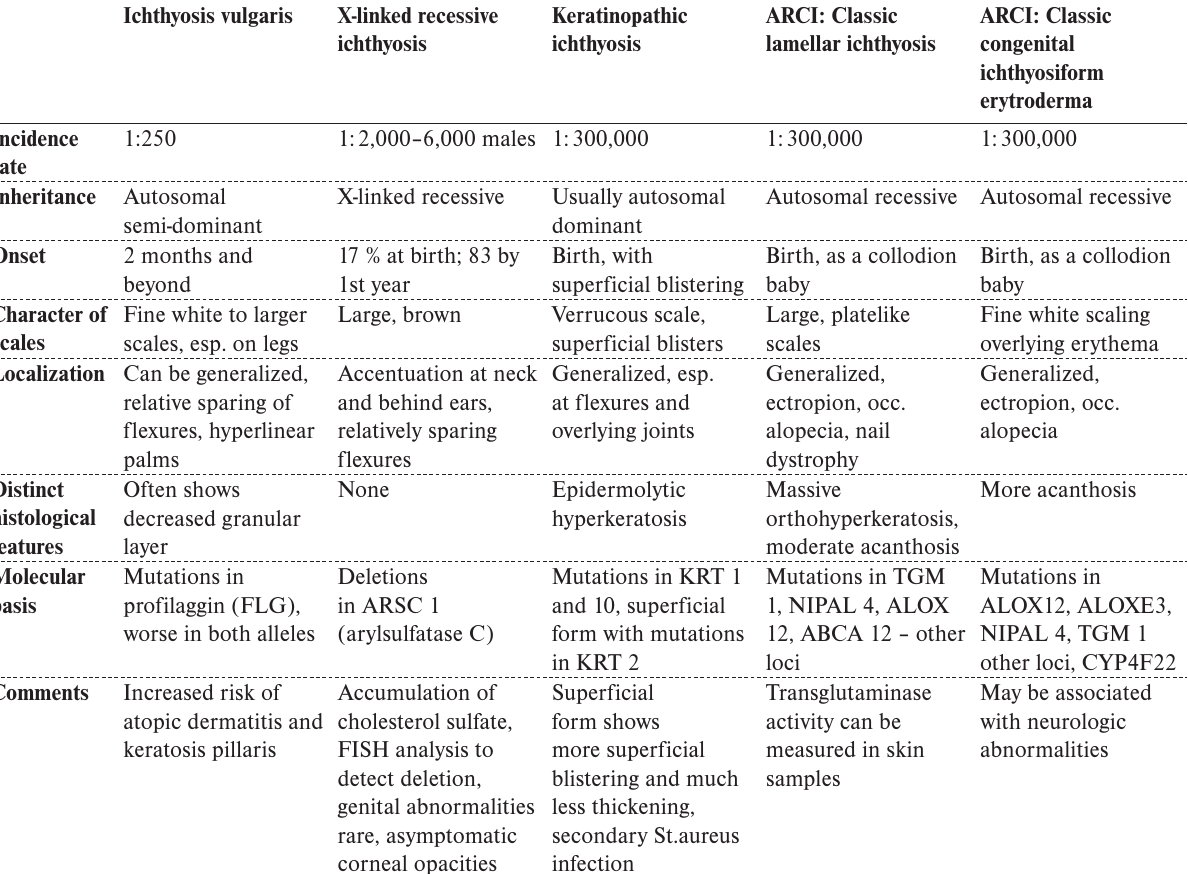
Table 1. Comparison of the most common types of ichthyosis. (ref.64